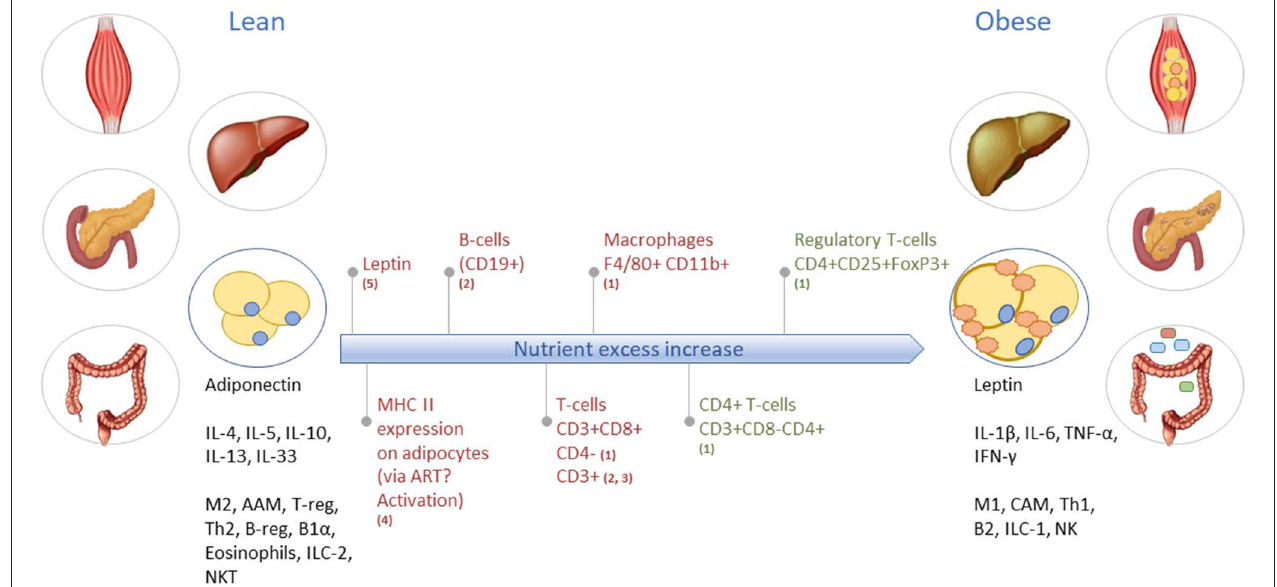
FIGURE 3 | Obesity-induced development of tissue inflammation in various organs. As an example, the long-term inflammatory dynamics and characteristics of lean toward obese WAT are illustrated. In lean WAT, immune cells are generally in an overall Type2 state (left black text), while in obese WAT the immune cells operate in a Type1 state (right black text). Red text indicates increase/abundancy of the mentioned adipokine and immune cells. Green text represents a decrease in the mentioned immune cell. M2, macrophage type 2; AAM, alternatively activated macrophages; T-reg, regulatory T-cells; Th2, T-helper type 2 cells; B-reg, regulatory